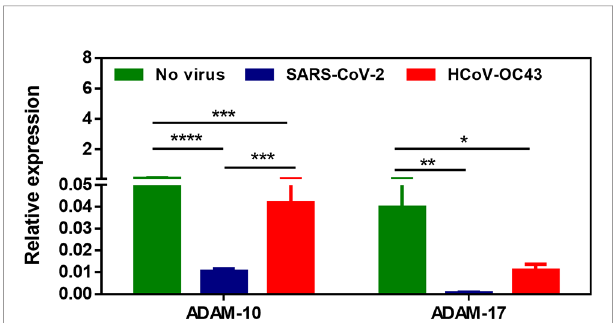
FIGURE 8 | Expression of ADAM-10 and ADAM-17 sheddases mRNA in virus-free Caco-2 cells or cells exposed to SARS-CoV-2 or HCoV-OC43 coronaviruses at an MOI of 0.5 for 24 hours. The results (n=8) are expressed as RE where RE = 2 ( − D CT). The symbol * means a p-value < 0.05; the symbol ** means a p-value < 0.01; the symbol *** means a p-value < 0.001; the symbol **** means a p-value <